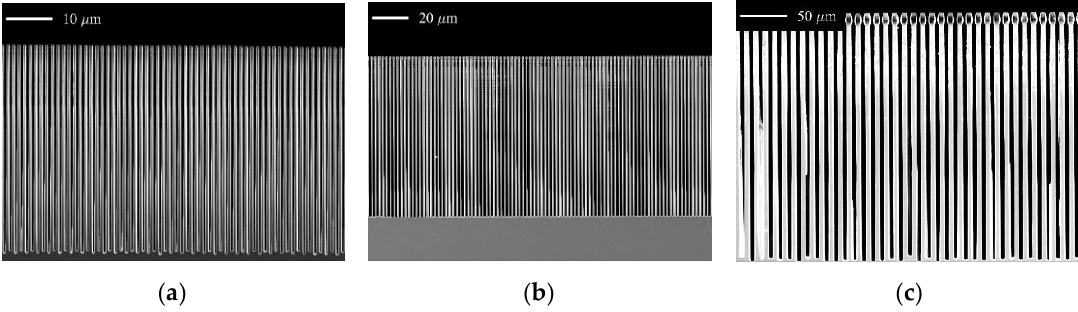
Figure 6. SEM images of cross-section of gratings. Grating period, height and aspect ratio: ( a ) p = 1.2 μm, h = 40 μm, α = 67; ( b ) p = 2 μm, h = 77 μm, α = 77; ( c ) p = 9.92 μm, h = 231 μm, α =